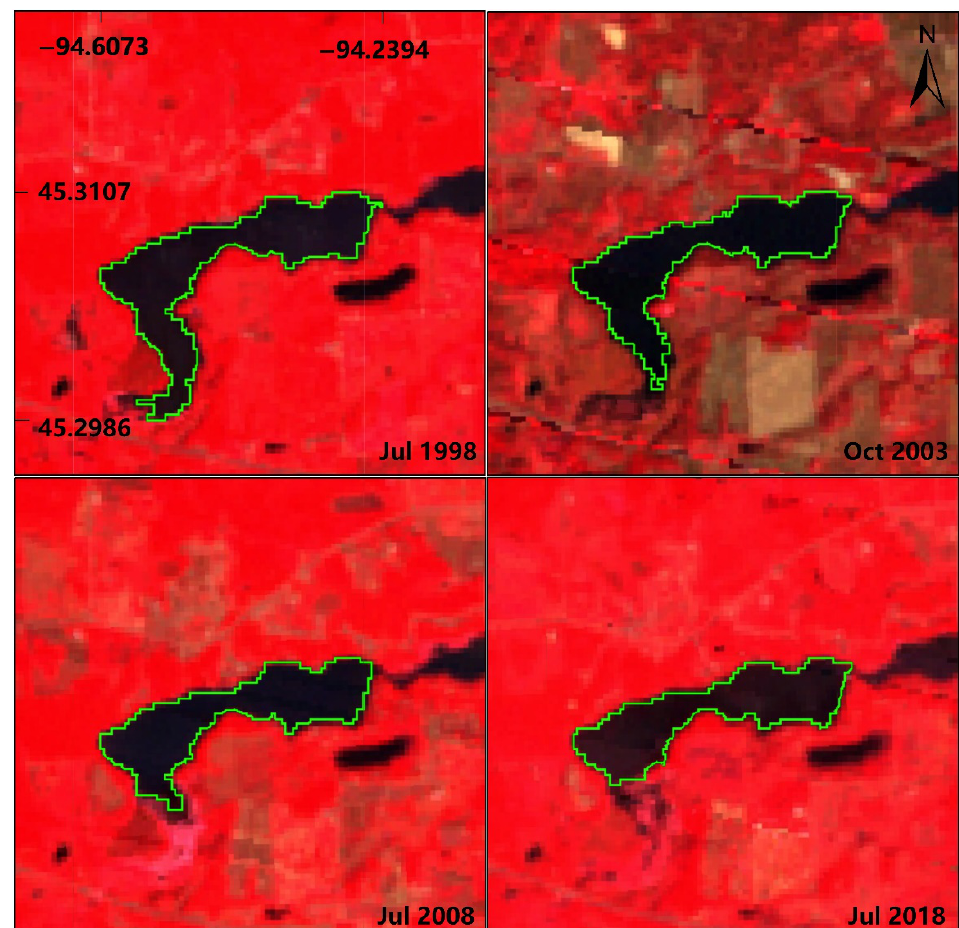
Figure 4. Multi-temporal water areas of Lake Louisa derived from the JRC Global Surface Water (GSW) dataset.